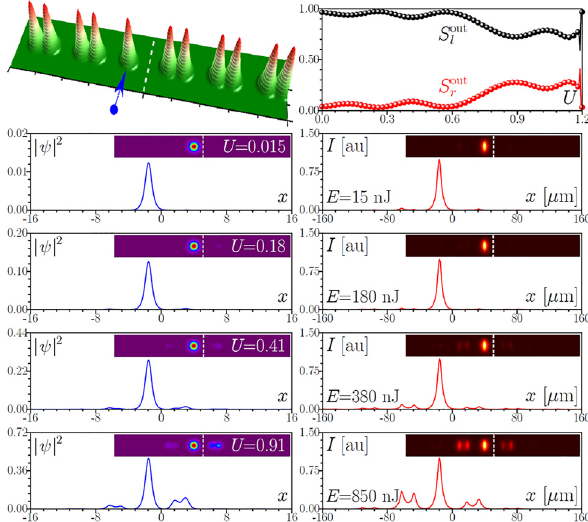
Figure 5: First row: Schematic representation of the interface between the topological and nontopological arrays with indication of the excited right outermost waveguide in the topological array and output power sharing between left, S out as a function of input power U . Second to fifth rows: Comparison of the theoretical (blue lines) and experimental (red lines) output intensity cross-sections at y = 0 and 2D intensity distributions (insets) for increasing energies E . Here s